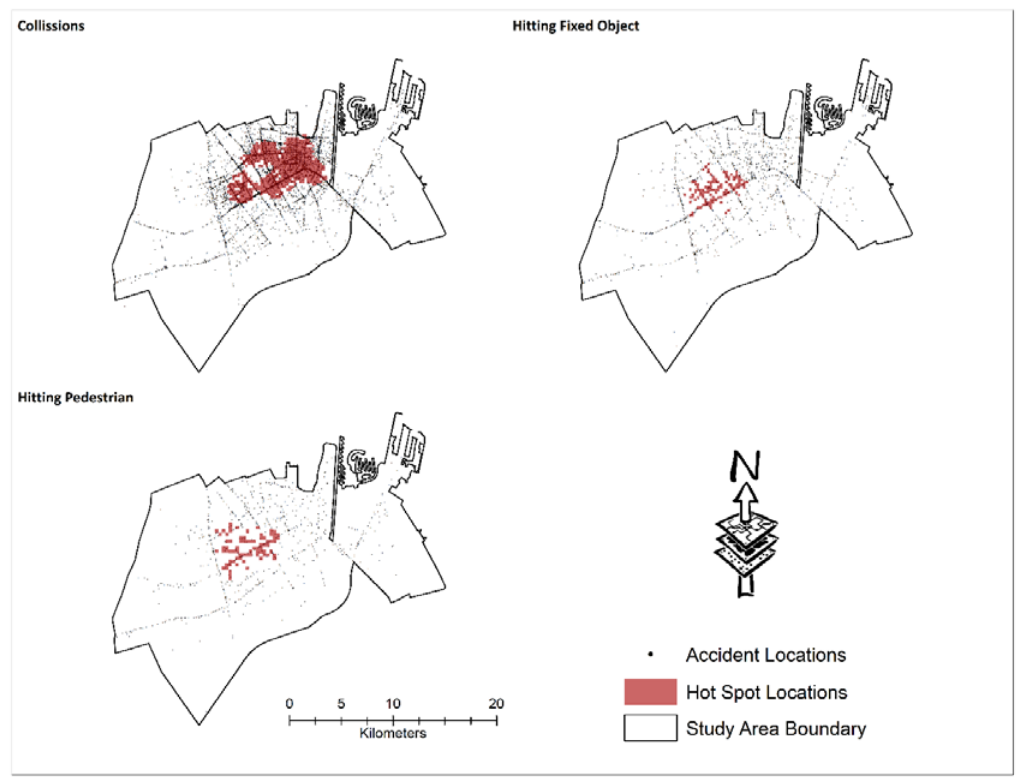
Figure 6. Distribution of hotspots by crash types.